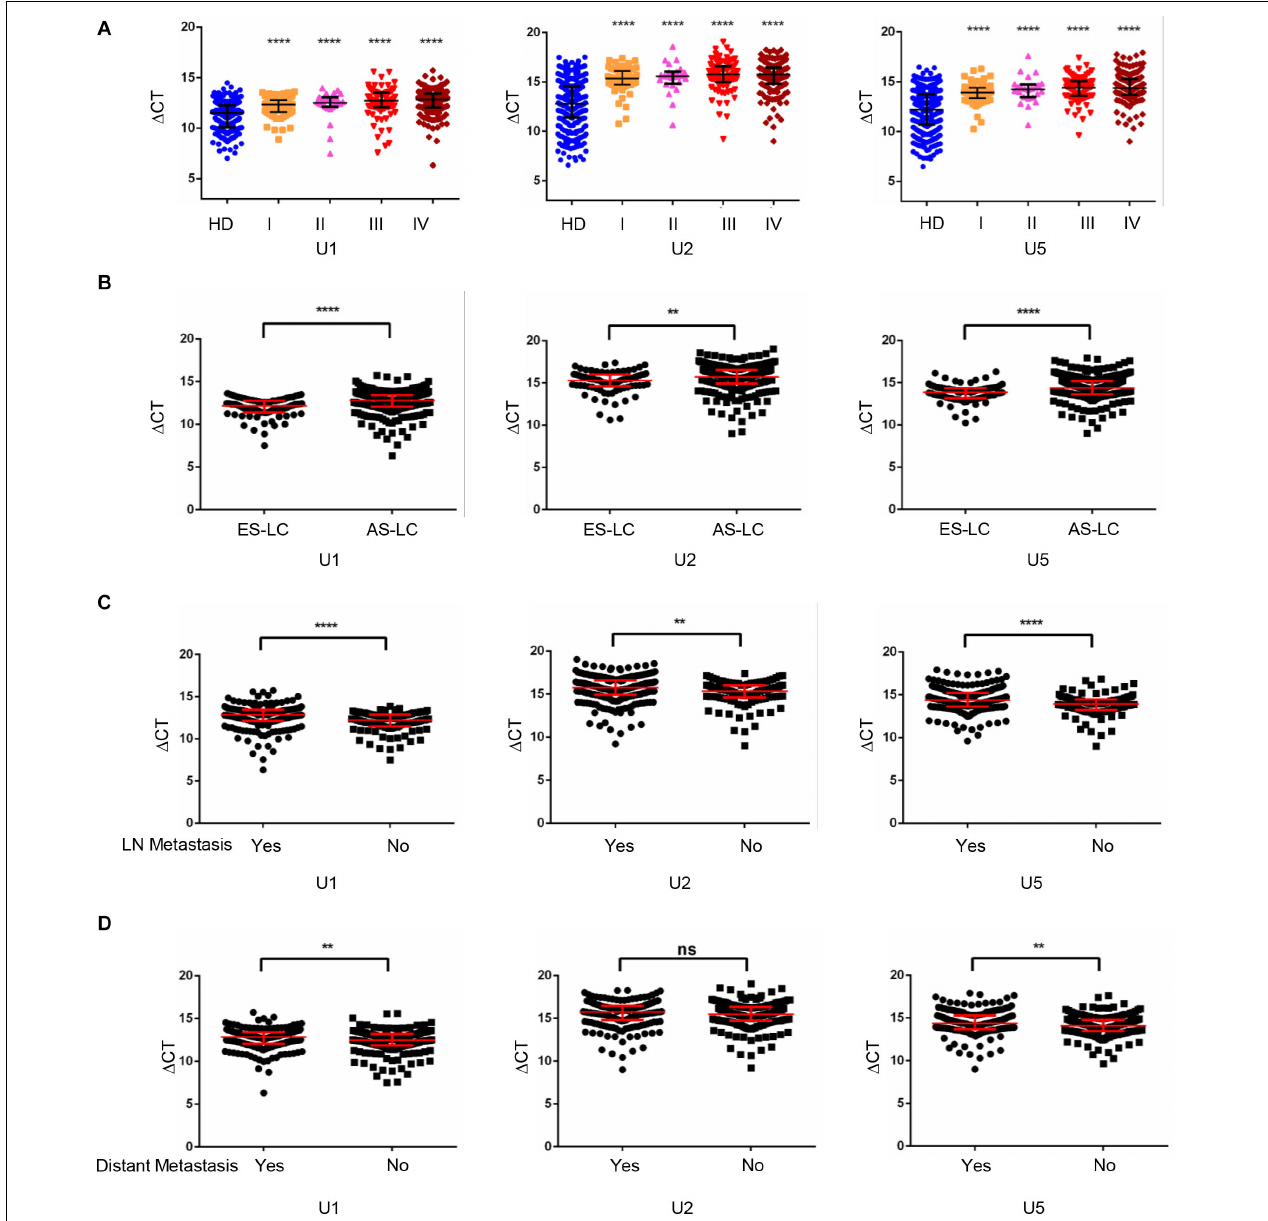
FIGURE 2 | TEP U1, U2, U5 downregulation correlated with lung cancer progression. (A) TEP U1, U2, U5 were down-regulated in in various TNM stage; (B) TEP U1, U2, U5 were down-regulated in advanced-stage lung cancer patients ( n = 274) compared with early-stage patients ( n = 80); (C,D) TEP U1, U2, U5 expression was lower in lymph node metastasis (C) and distant metastasis (D) group than in control group. AS-LC, advanced-stage lung cancer patients; ** p < 0.005; **** p < 0.0001; ns, no